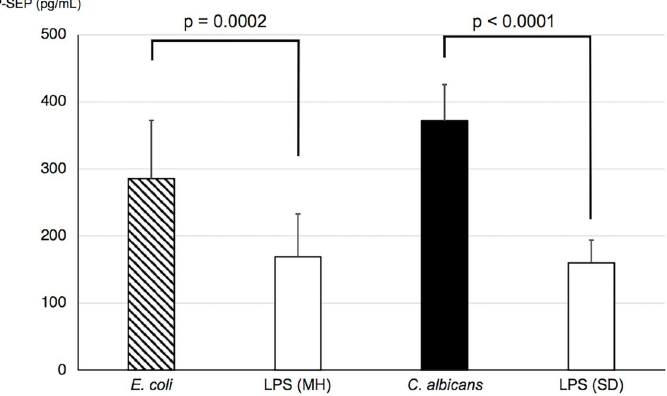
Fig 3. Presepsin levels in the whole blood incubated separately with C . albicans and E . coli . Compared with the whole blood sample incubated with LPS, those that were separately cultured with C . albicans and E . coli had significant increases in P-SEP levels in the supernatant. The increase in P-SEP levels was not different between the C . albicans and E . coli cultures. MH, Mueller–Hinton broth; SD, Sabouraud–Dextrose